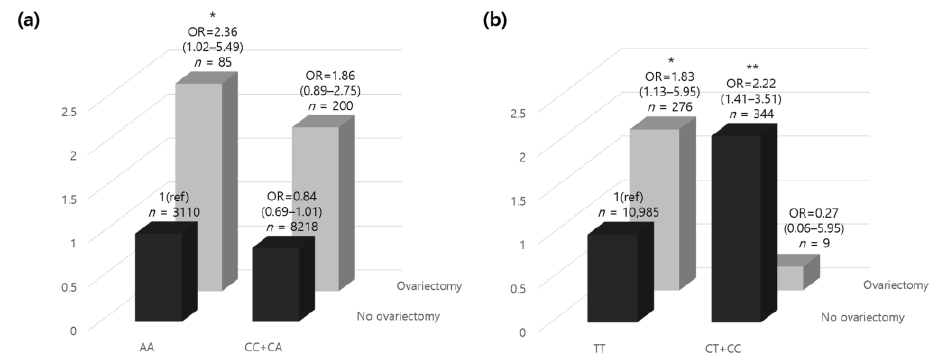
Figure 2. The relative odds ratio of osteoporosis according to oophorectomy and ( a ) MYLK rs12163585 and ( b ) PTGS1 rs1213265 genotypes. The ORs (95% CI) of the genetic correlation between dominant/homozygous genotypes of each gene and ovariectomy are shown. The homozygous model was set as the reference allele. p -values were adjusted for age and residential area by analysis of covariance. * p < 0.05, ** p < 0.01. Abbreviations: OR, odds ratio; CI, confidence